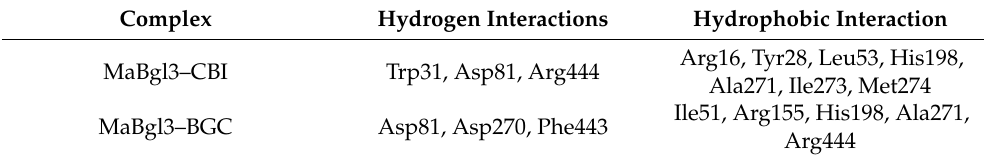
Table 5. Hydrogen and hydrophobic interactions with the amino acid residues of MaBgl3. Complex